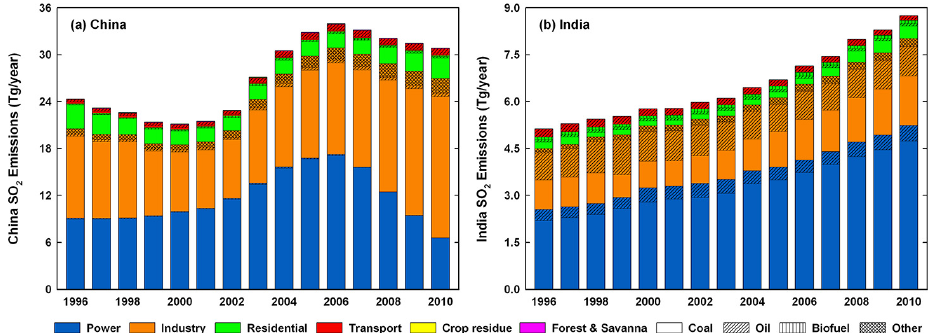
Fig. 2. SO 2 emissions by sector and fuel type in (a) China and (b) India during 1996–2010.